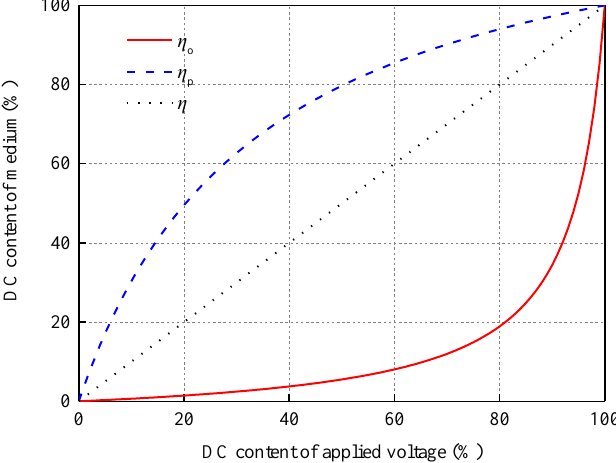
Figure 10. DC contents of transformer oil and pressboard.